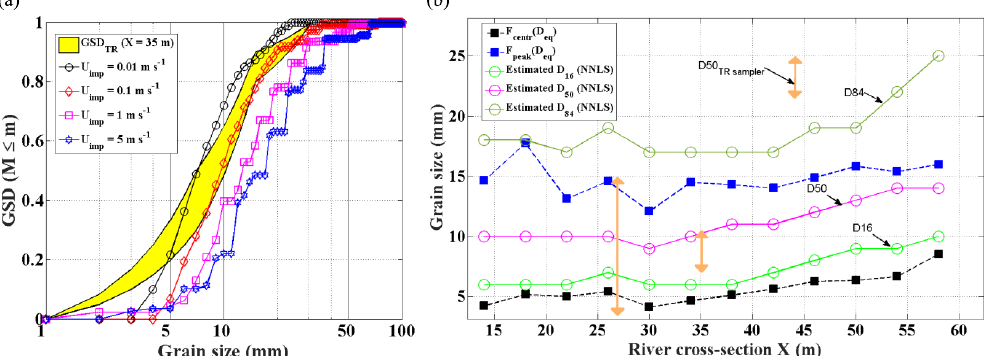
Figure 9. (a) Estimated GSD by the NNLS algorithm in the center of the Isère River ( X = 34m), using different values of impact velocities U imp = {0.01, 0.1, 1, 5} m s − 1 . Measured GSD by TR sampler ( X = 35m) is represented by the yellow envelope for the two mesh sizes (see Fig. 9b for fraction sizes finer than 1mm); (b) The D 16 , D 50 , and D 84 estimated by NNLS across the Isère River compared to the regression laws of Thorne (1985, 1986b) for estimating the equivalent diameter D eq ; we also indicate by arrows the range of D 50 measured by the Toutle River sampler (in positions X = { 27 , 35 , 44 } m). The impact velocity used in the inversion is U imp = 1ms − 1 .